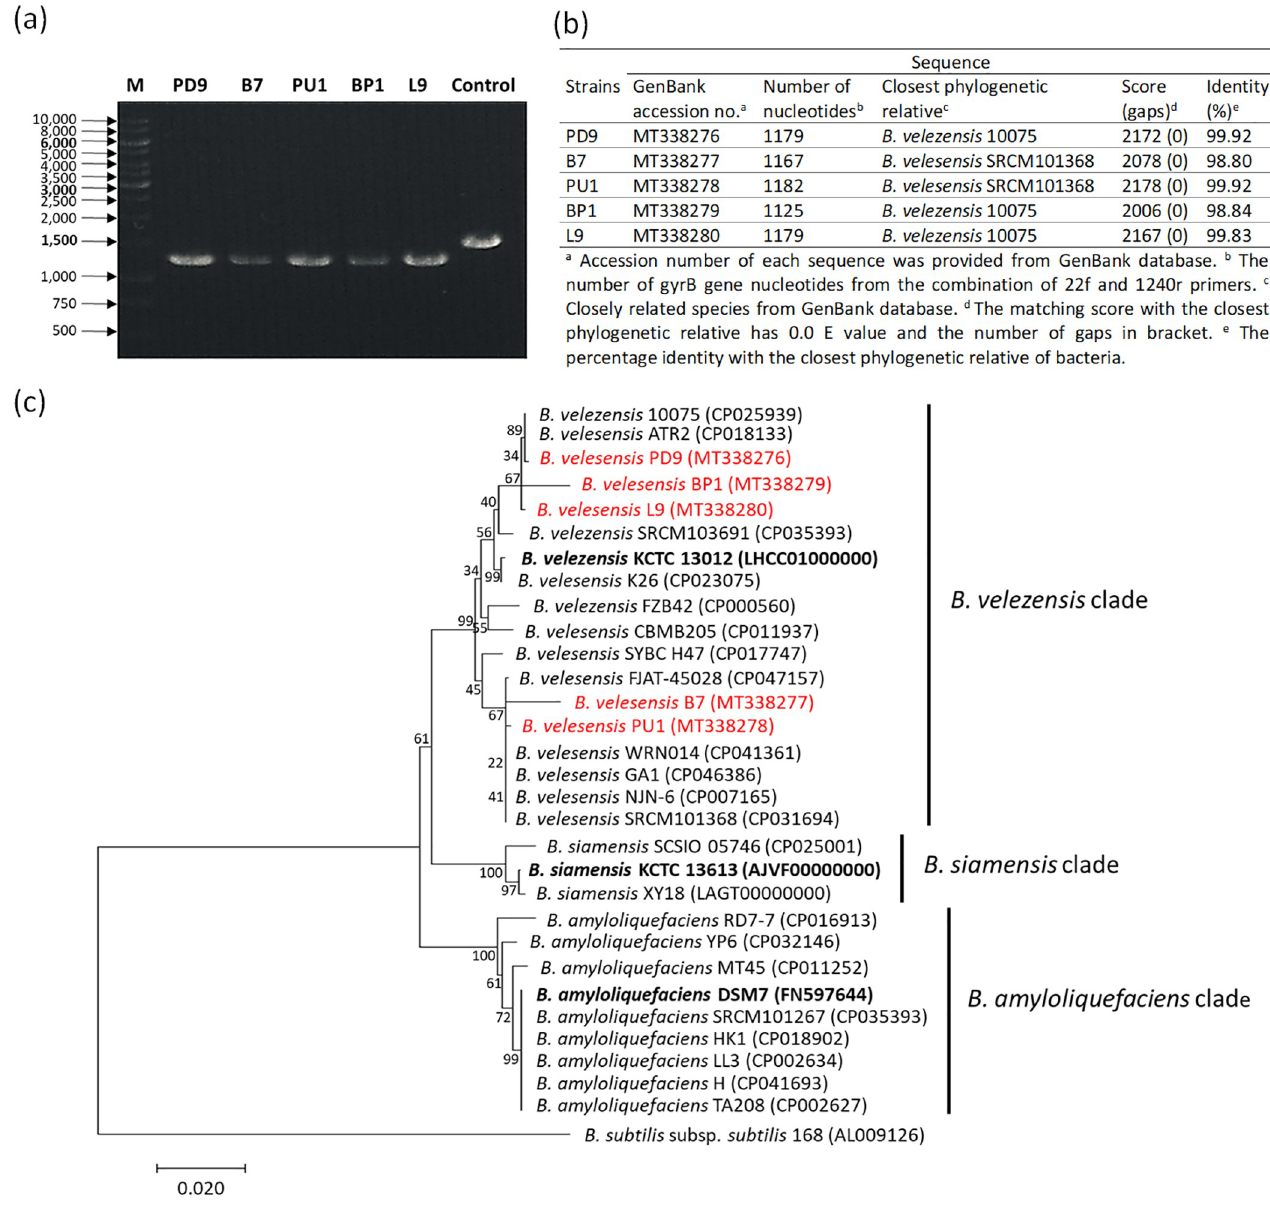
Fig 1. Analysis of gyrB sequence. (a) The gyrB (approximately 1,200 bp) of B . velezensis strains were amplified using PCR. The bacterial strains are labelled at the top of the gel photo. “M” = Marker GeneRuler 1 kb Plus DNA ladder (Thermo Fisher Scientific, USA). (b) The comparison of gyrB sequences of B . velezensis strains with the gyrB sequence in GenBank. (c) The gyrB phylogenetic analysis within the B . amyloliquefaciens operational group. Type strains are in bold and the bacterial strains used in this study are in red. B . subtilis subsp. subtilis 168 was chosen as an outgroup.